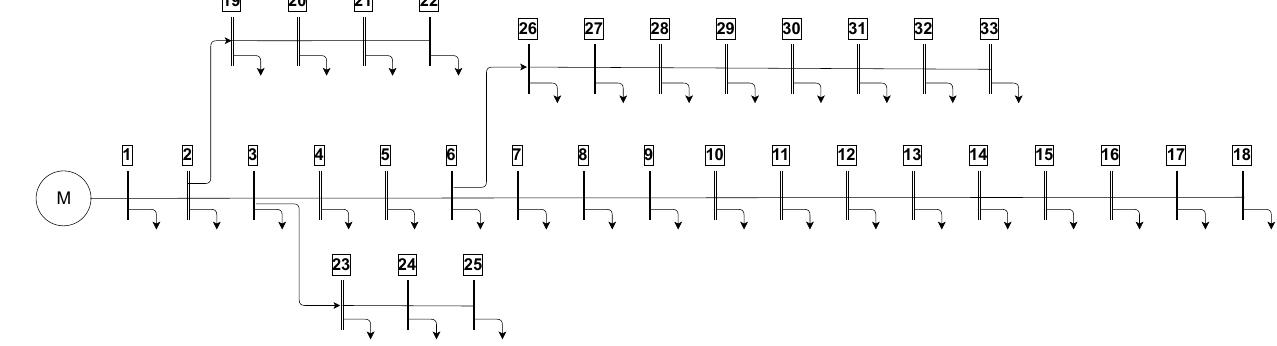
Figure 2. The line diagram of the 33-bus test